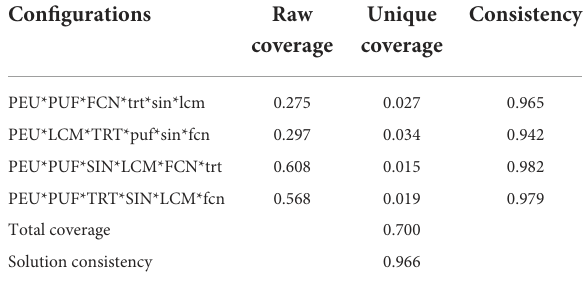
TABLE 9 Configuration of higher intention to use smart wearable payment